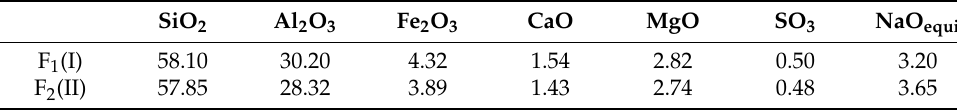
Table 1. The chemical composition of fly ash